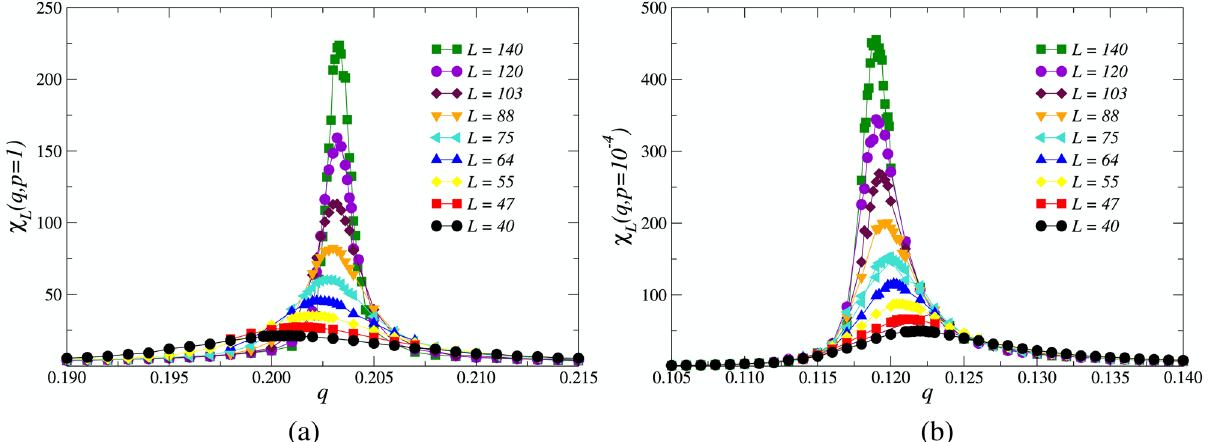
Figure 6. Magnetic susceptibility peaks for different system sizes and ( a ) p = 1 and ( b ) p = 10 − 4 . For large values of p , the pseudocritical points q c ( L ) shift to higher values of q with increasing system size L . For low values of p , the the peaks of the susceptibility, and thus the pseudocritical points, shift to lower values of q with increasing L .